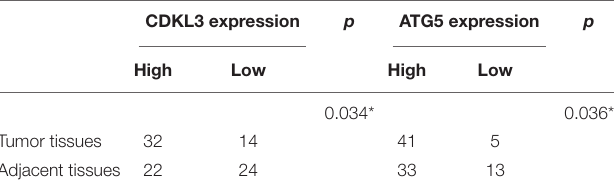
TABLE 1 | Differential expression of CDKL3 and ATG5 in 46 paired ESCC and adjacent tissues. CDKL3